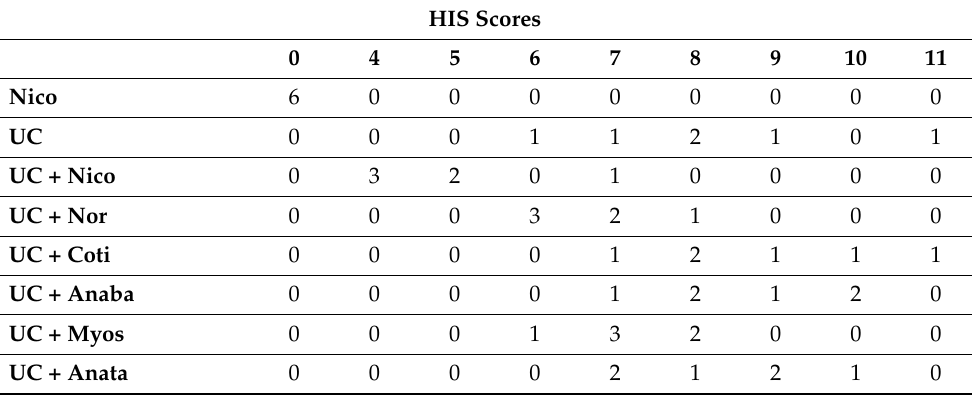
Table 3. Number of rats per each HIS score at Day